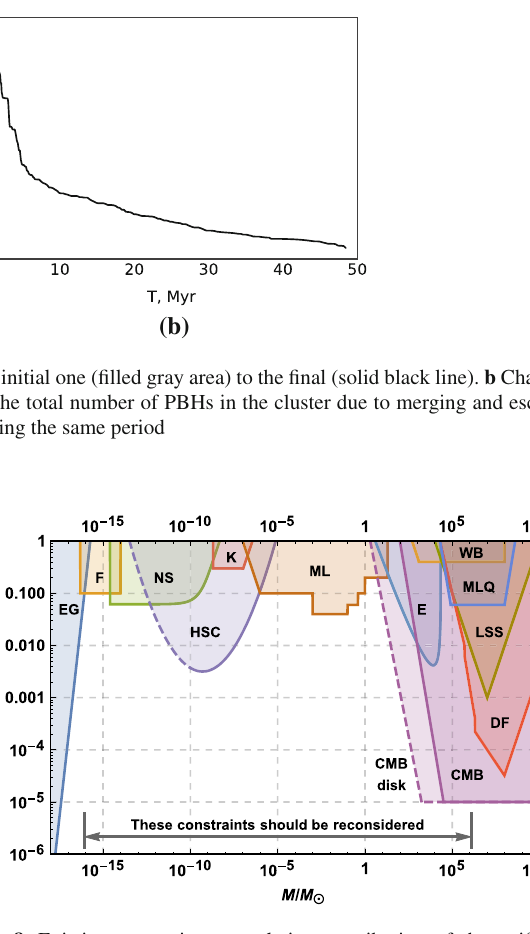
Fig. 8 Existing constraints on relative contribution of the uniform PBHs distribution into dark matter density with monochromatic mass distribution. The most robust constraints in their regions are basically depicted following the notation of [91]: from extragalactic gamma-ray background (EG) observation, femtolensing (F), neutron star destruc- tion (NS), searches for gravitational microlensing events by Subaru Hyper Suprime-Cam (HSC), Kepler satellite (K), MACHO (ML), quasars millilensing (MLQ), wide binary (WB) and star cluster in Eri- danus dwarf galaxy (E) destruction, CMB distortion due to accretion effects (WMAP), effects of dynamical friction in our Galaxy (DF) and large-scale structure (LSS). CMB constraint was taken for (more minimal) case of spherically symmetric accretion [17] in comparison with the less minimal (“CMB disk”) one [91] (shown by dashed line). Double-headed arrow shows region where the constraints are to be re- considered for PBH